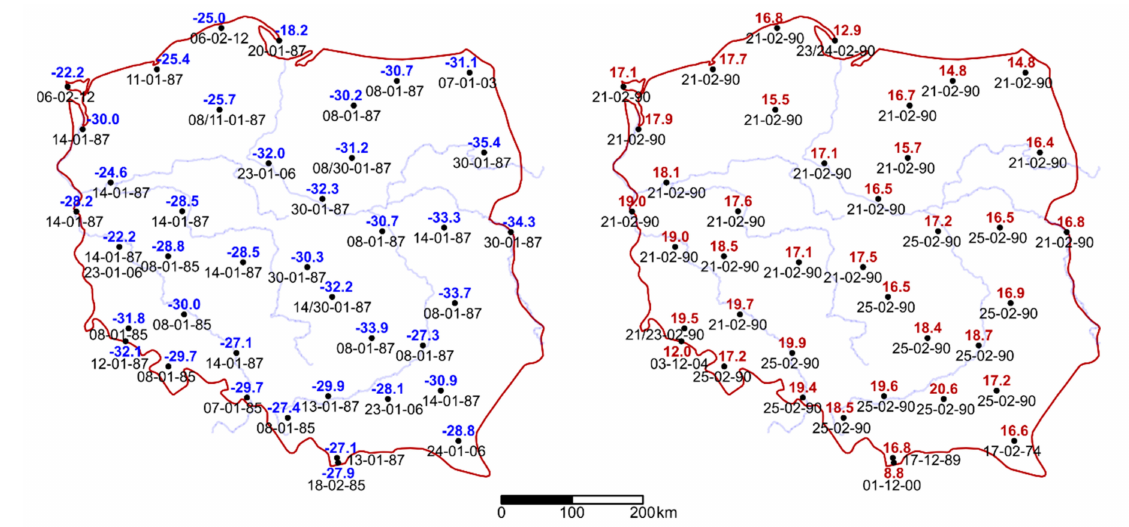
Figure 4. Lowest daily Tmin ( left map ) and highest daily Tmax ( right map ) in winter in the years